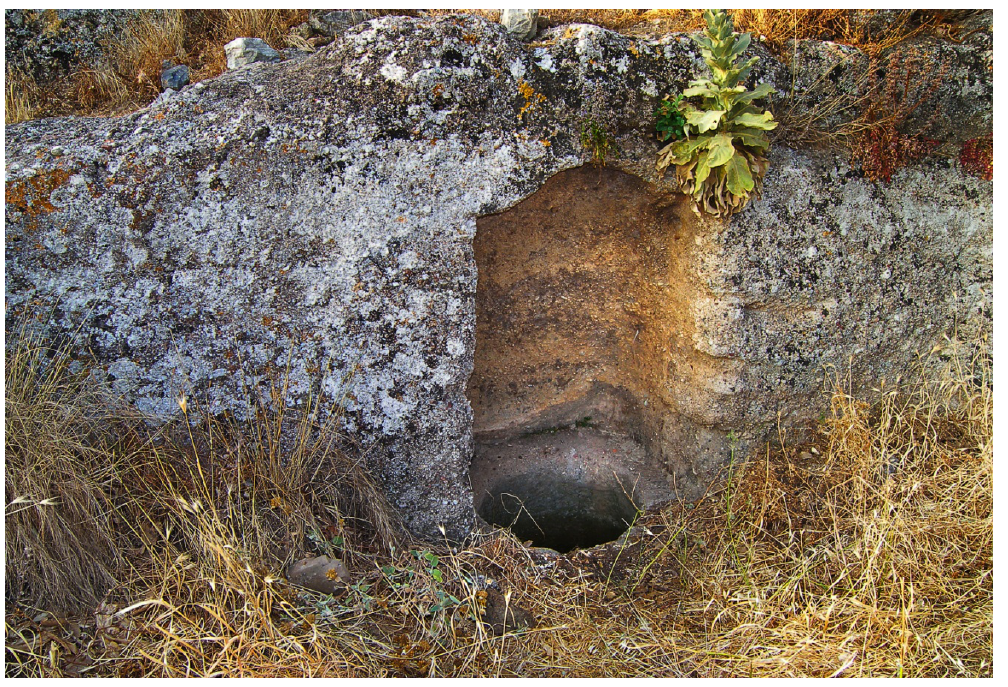
Figure 5. Mouth of subterranean cistern in a Hellenistic house in the ancient town of